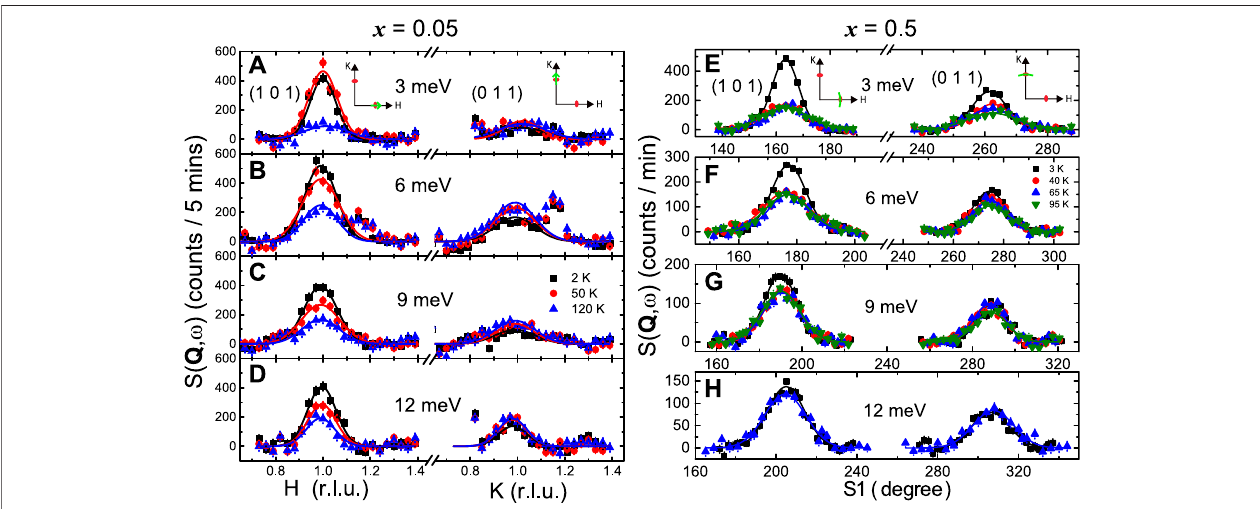
FIGURE5| (Coloronline)Inelasticneutronscatteringresultsonthespinexcitationsofuniaxiallydetwinnedsamplesfor x =0.05(left)and x =0.5(right)compounds measured by two triple-axis spectrometers TAIPAN and PUMA. We compared the constant-energy scans ( Q − scans along [ H ,0,1] or [0, K ,1], S 1 rocking scans at Q = (1,0,1) or (0, 1, 1)) for E = 3, 6, 9, 12 meV, respectively. All data are corrected by a linearly Q − dependent background, and the solid lines are Gaussian fi ttings. The spurious signals in 6 meV data are ignored.